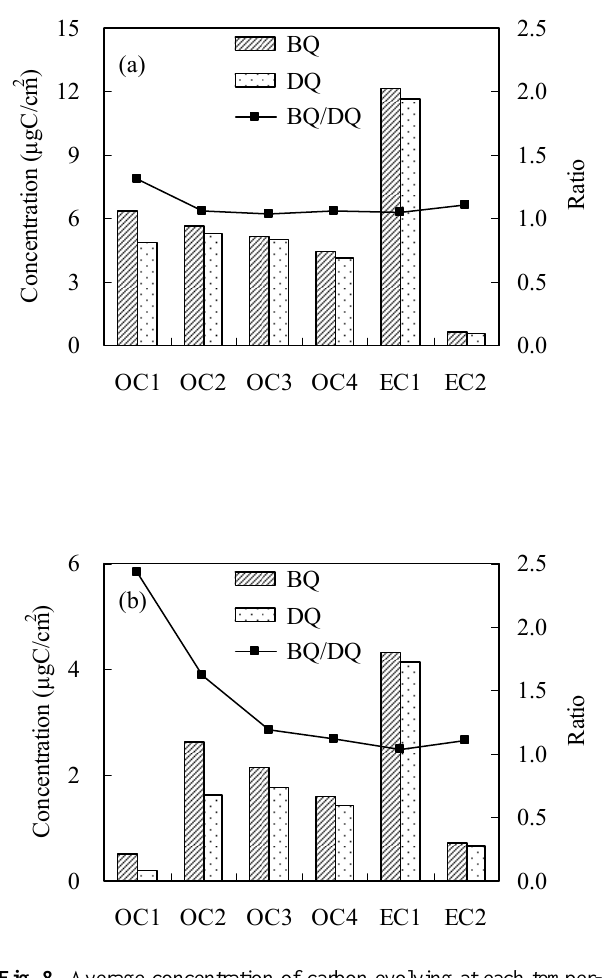
Fig. 8. Average concentration of carbon evolving at each temper- ature step. (a) results from denuded (DQ) and undenuded (BQ) Figure 8. Average concentration of carbon evolving at each temperature step. (a) results from quartz filters collected during winter; (b) results from summer sam- denuded (DQ) and undenuded (BQ) quartz filters collected during winter; (b) results from summer ples. BQ to DQ ratio of each carbon fraction (BQ/DQ) is also samples. BQ to DQ ratio of each carbon fraction (BQ/DQ) is also shown.